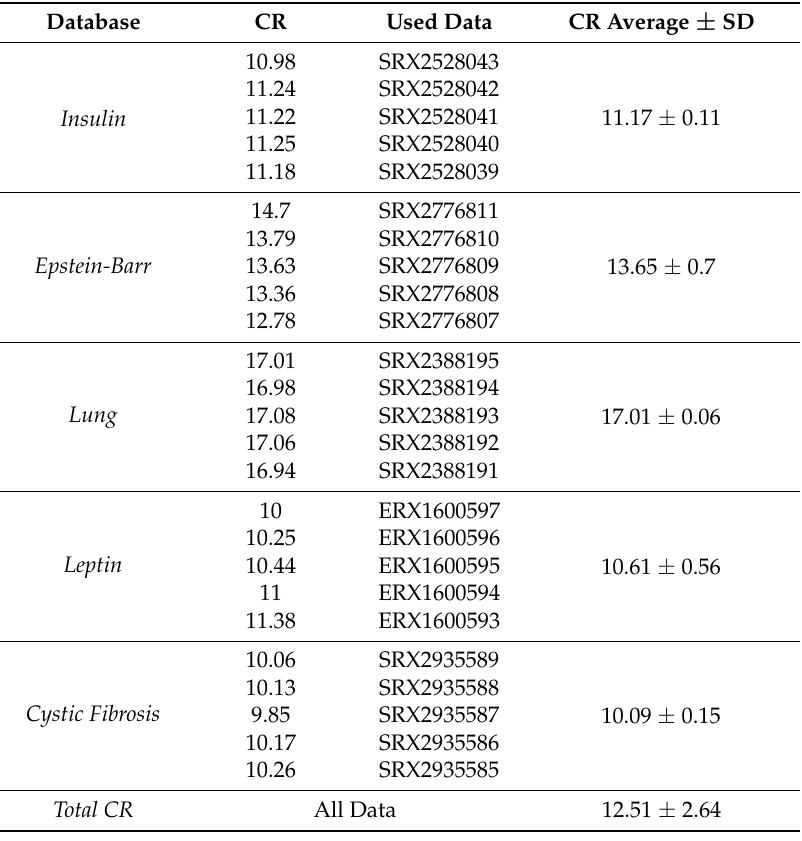
Table 2. CR Results of BAQALC for Five Disease